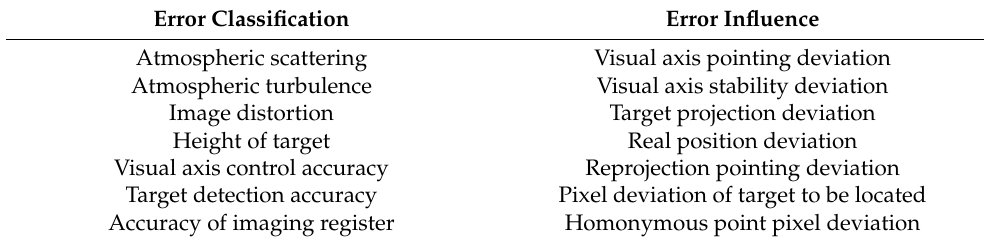
Table 3. Analysis of often ignored